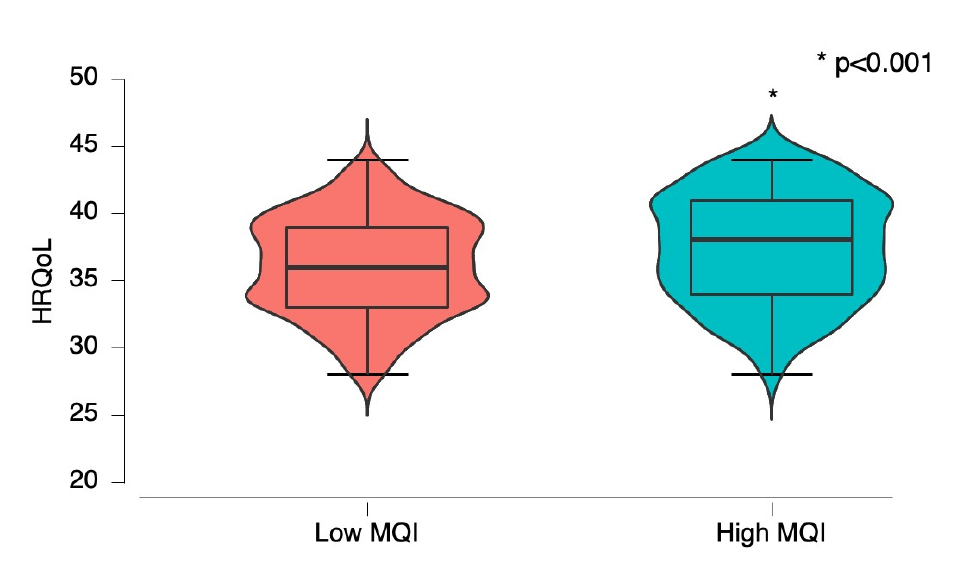
Figure 1. Health related to quality of life (HRQoL) according to muscle quality index (MQI); low MQI vs. high MQI.